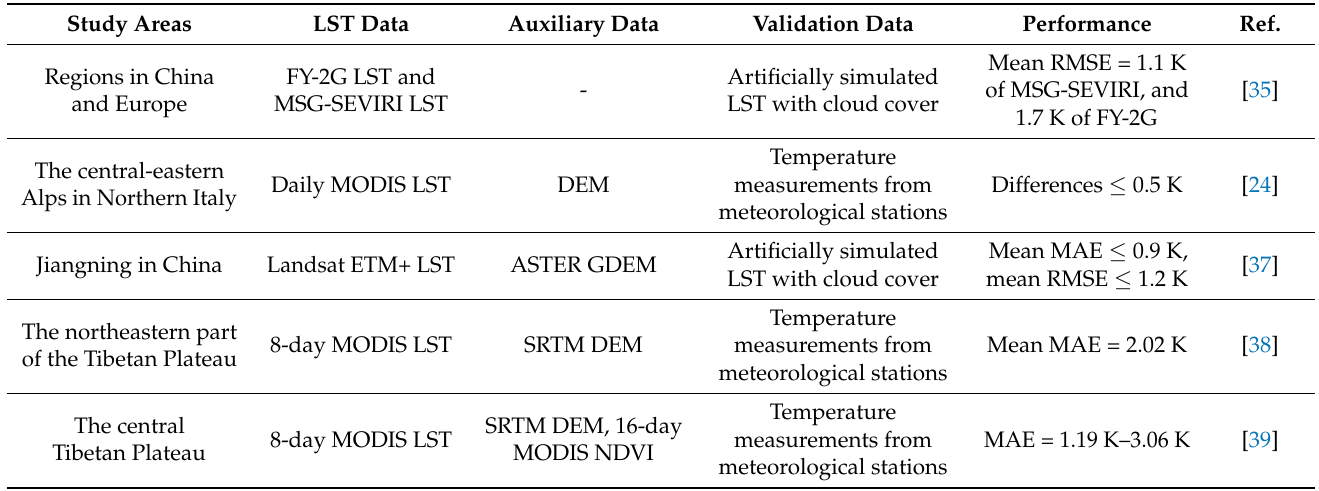
Table 4. Summary of spatial gap-filling